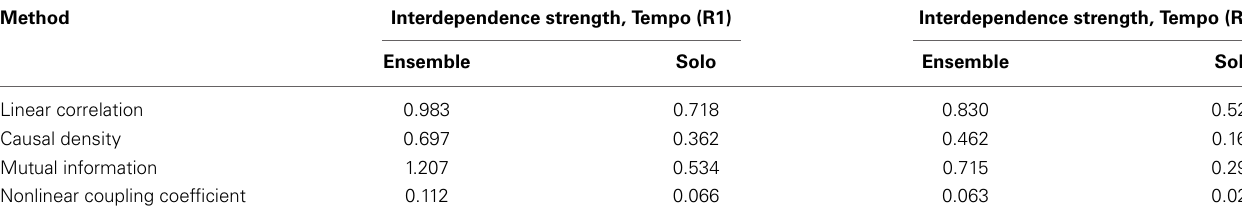
Table 5 | Interdependence strength for the Tempo dimension, per exercise and experimental